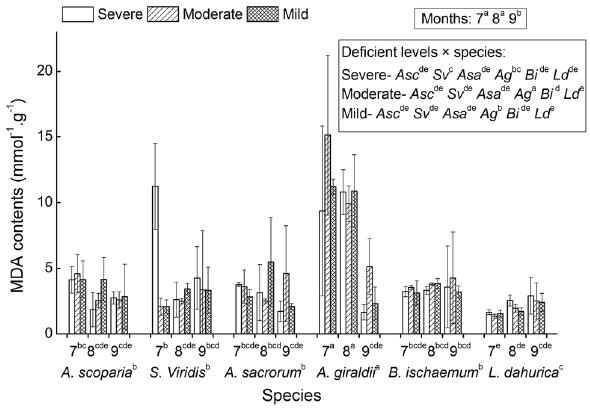
Figure 5. MDA contents of six successional seral species . The MDA contents were measured on July (7), August (8) and September (9) under three water deficient levels (severe, moderate and mild). Significant multi-comparison results of month 6 species and species were marked on the first and second label rows of X-axes. Significant multi-comparison results of month and deficient level 6 species were marked as legends within two blocks (see associated ANOVAs results of Table 1). In the box of legend zone, species of A. scoparia, S. viridis, A. sacrorum, A. giraldii, B. ischaemum and L. dahurica were abbreviated as Asc, Sv, Asa, Ag, Bi and Ld ,